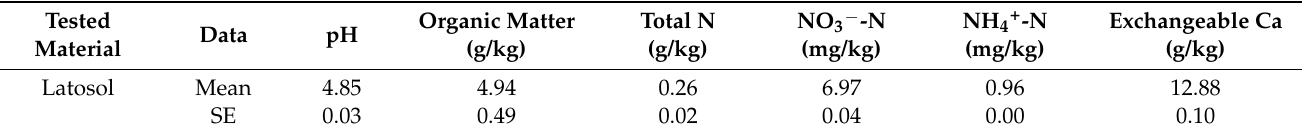
Table 1. Basic physicochemical properties of the tested